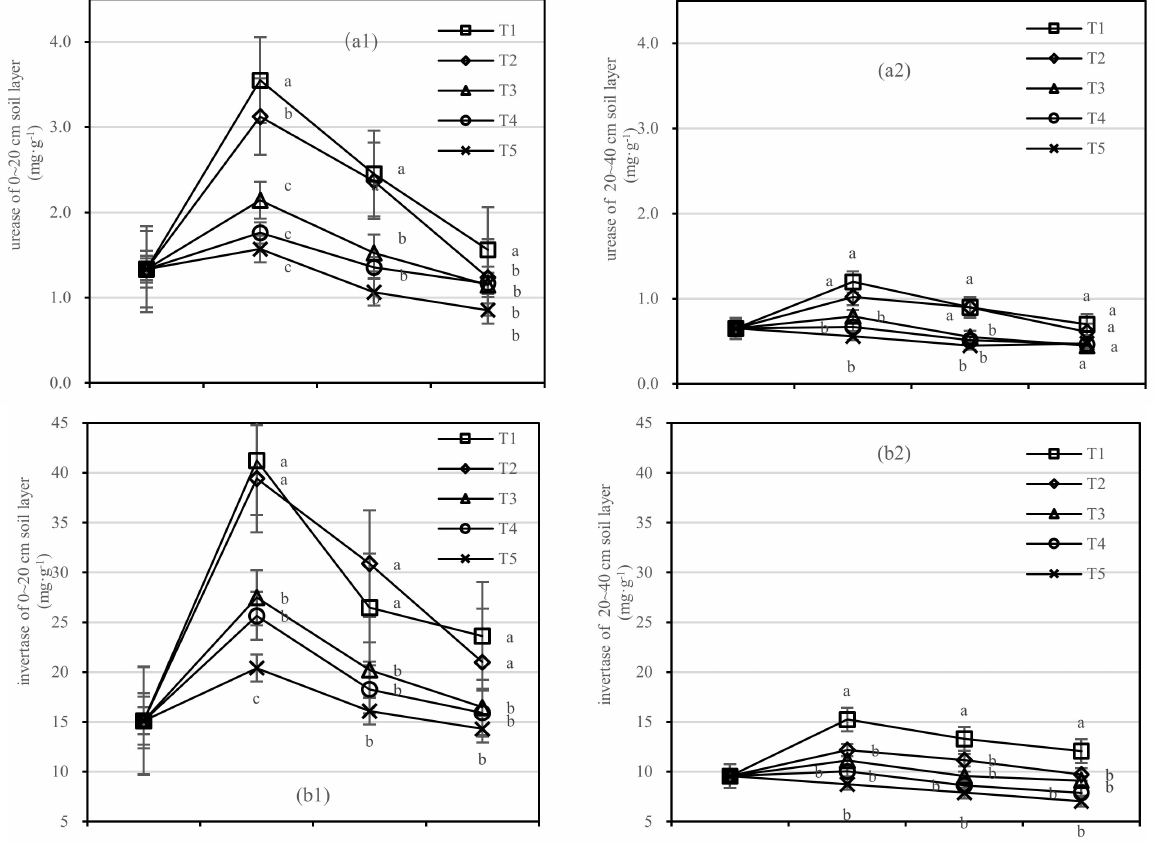
Figure 6. Soil urease and invertase activities in four periods under five fertilization types. Data are the mean content ± standard deviation. Letters represent differences ( α = 0.05). T1: adjustment of C/N and C/P + 0.2% priming; T2: adjustment of C/N and C/P + 0.2% common compost; T3: adjustment of C/N and C/P; T4: raw material grinding of thinning shreds; T5: no fertilization. Additionally, ( a1 , a2 ) and ( b1 , b2 ) describe the contents of soil urease and invertase in the 0–20 cm and 20–40 cm soil layers,